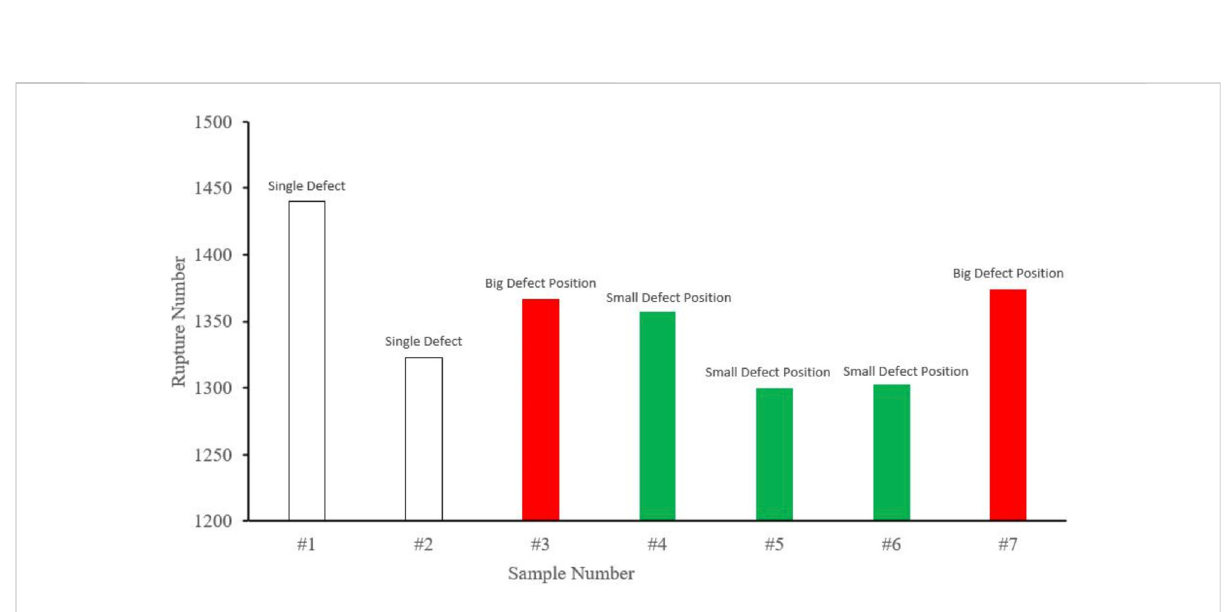
FIGURE 11 Rupture perimeter and rupture positions of seven